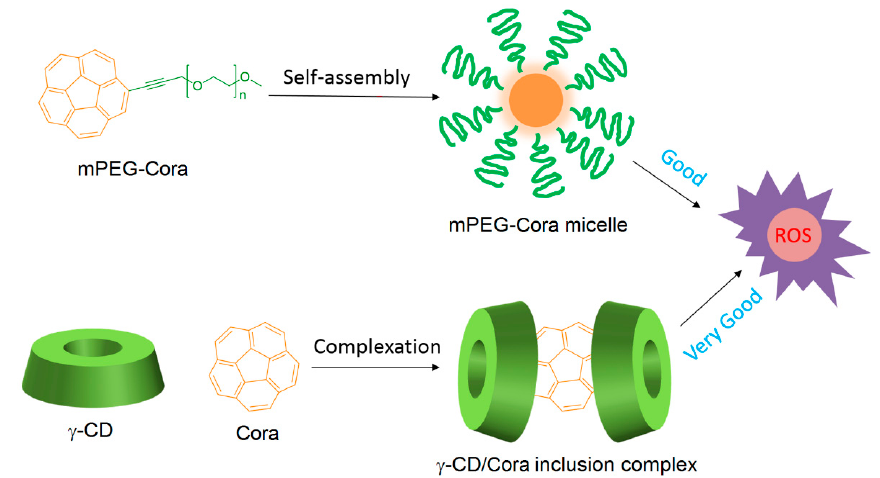
Figure 16. Two types of Corannulene (Cora) solubilization vehicles. The γ -CD/Cora inclusion complex is proposed to have a better ability for apparent ROS generation compared to the self-assembling methoxy poly(ethylene glycol)-corannulene (mPEG-Cora) micelle. Adapted from Zhang; Dong; Lu; Liu; Ding; Kong; Fan; Wang; Zhao [132].